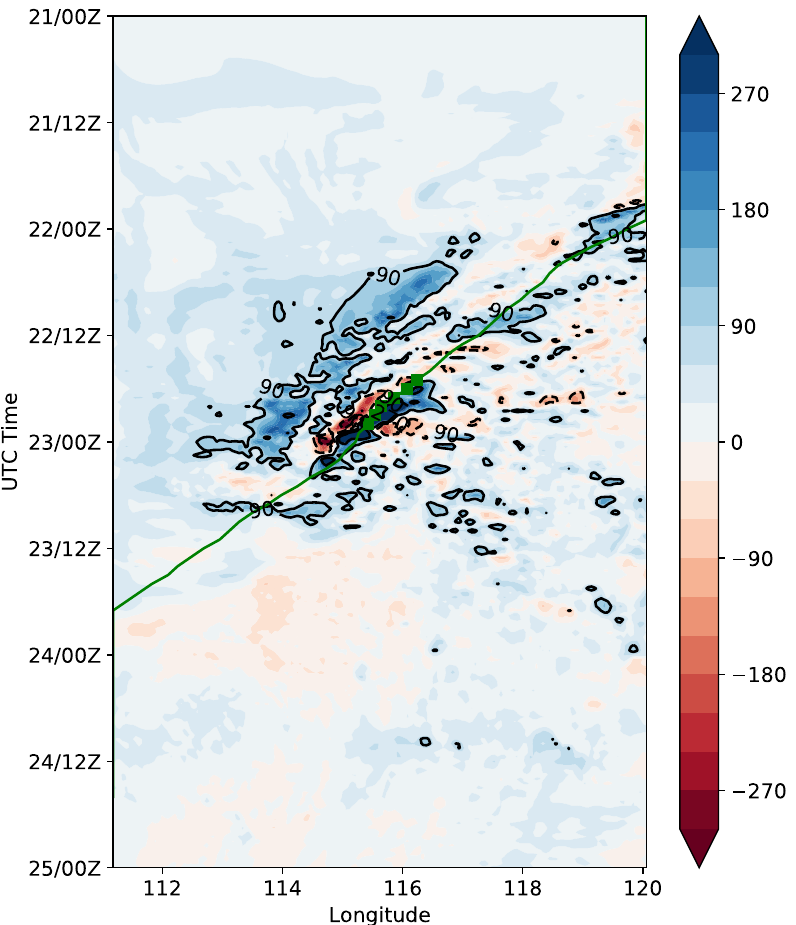
Fig. 6 Differences in latent heat fl ux between the control and NORAD runs. Hovmöller diagram of latent heat fl ux differences in W m − 2 between the control and NORAD experiments of Typhoon Hato along the edge of the continental shelf between Hainan and Taiwan islands. Green lines represent the nearest point of the line to Hato, with squares indicating the distance less than 10